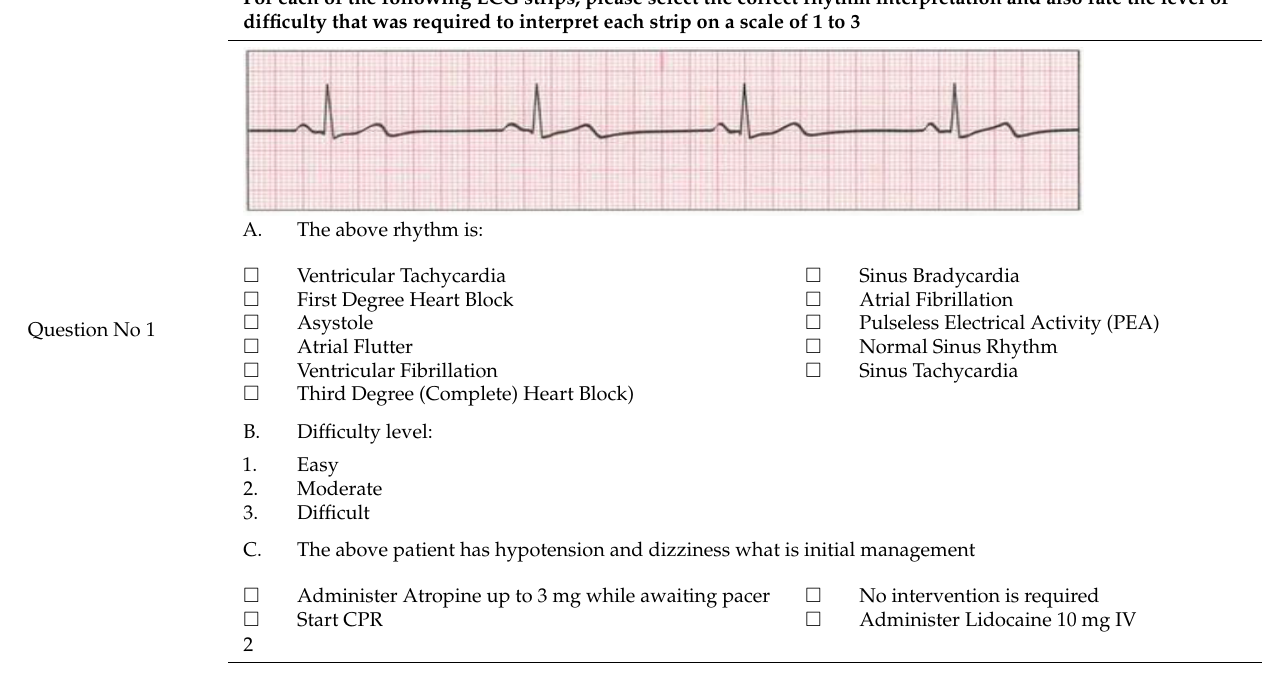
Table 1. Example of the questionnaire